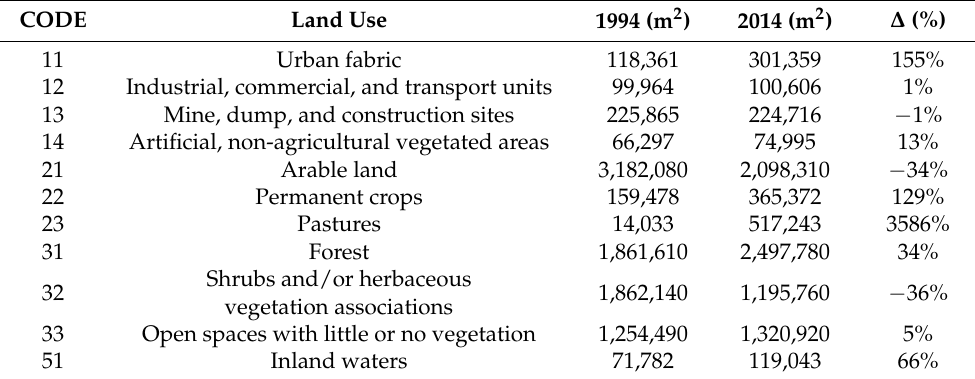
a revegetation process. In fact, forest areas increased by 34% (Table 3), while areas with little or no vegetation slightly increased, by 5% (Figure 13). Table 3. Land use change in the period 1994–2014 in the study